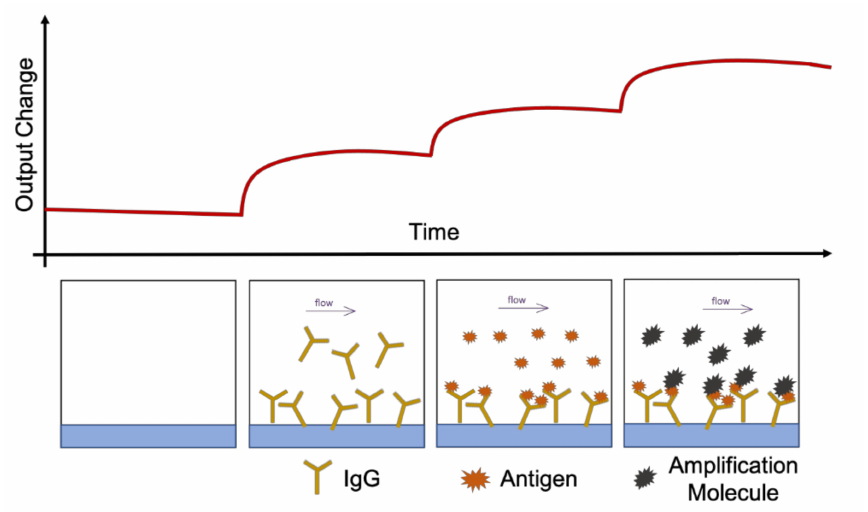
Figure 7. Schematic Illustration of Silicon Photonics Biosensing. As biomolecules bind to waveguides, the refractive index around the waveguide changes; these changes depend primarily on the molecular weight of the bound species and lead to changes in intensity measured by